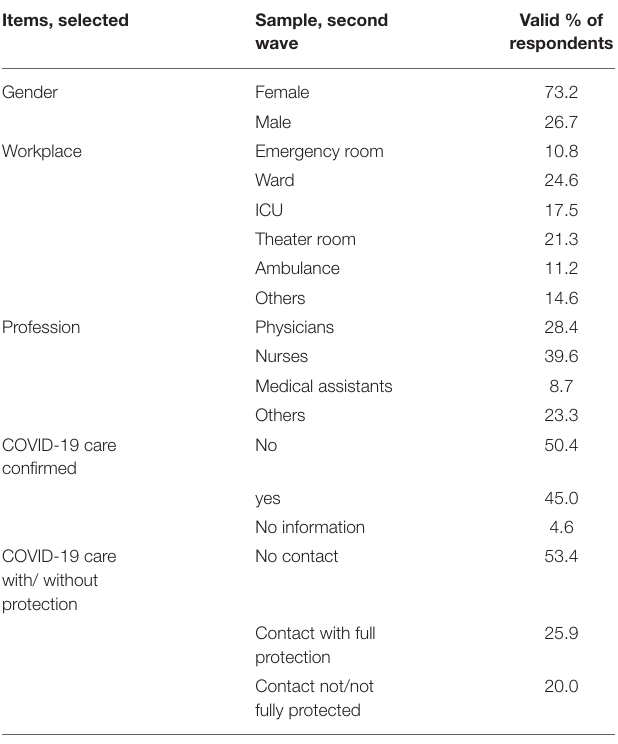
TABLE 3 | Perceptions of fear of infection at the workplace and in the private sphere, valid percentage of participants.